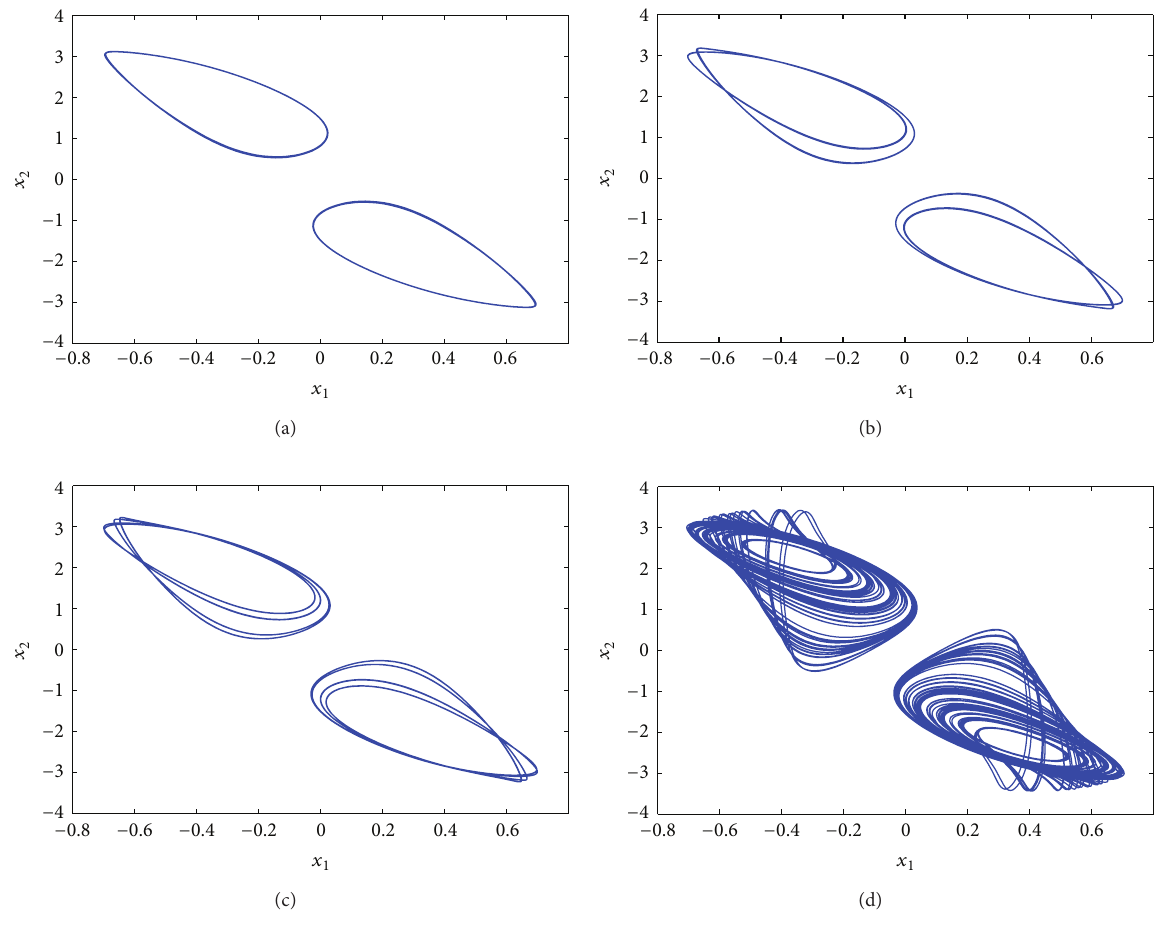
Figure 4: Different dynamical behaviors of system (13) with fixed parameter values 𝑏 22 = 3.0 , 𝑐 22 = −2.5 and two groups of initial conditions (0.4, 0.6) 𝑇 and (−0.4, −0.6) 𝑇 for 𝑡 ∈ [−1,0] , respectively; (a) period-one orbits when 𝛼 = 0.78 ; (b) period-two orbits when 𝛼 = 0.79 ; (c) period-four orbits when 𝛼 = 0.80 ; (d) separate single-scroll chaotic attractors when 𝛼 = 0.83 .